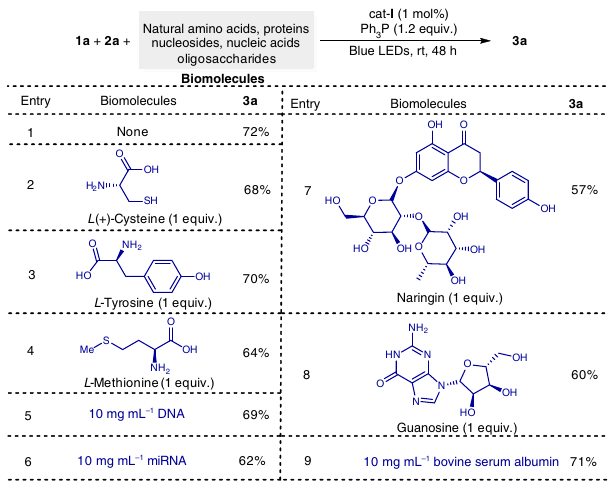
Fig. 4 Examining functional group compatibility. Reaction conditions: photocatalyst I (1 mol%), 1a (0.1 mmol, 1.0 equiv.), 2a (0.15 mmol, 1.5 equiv.), Ph 3 P (0.12 mmol, 1.2 equiv.), biomolecules, pH 7.4 PBS buffer/DCM (1:1, 2.0 mL), blue LEDs, 25 synthetically useful yields, clearly demonstrating the robustness of this synthetic protocol.